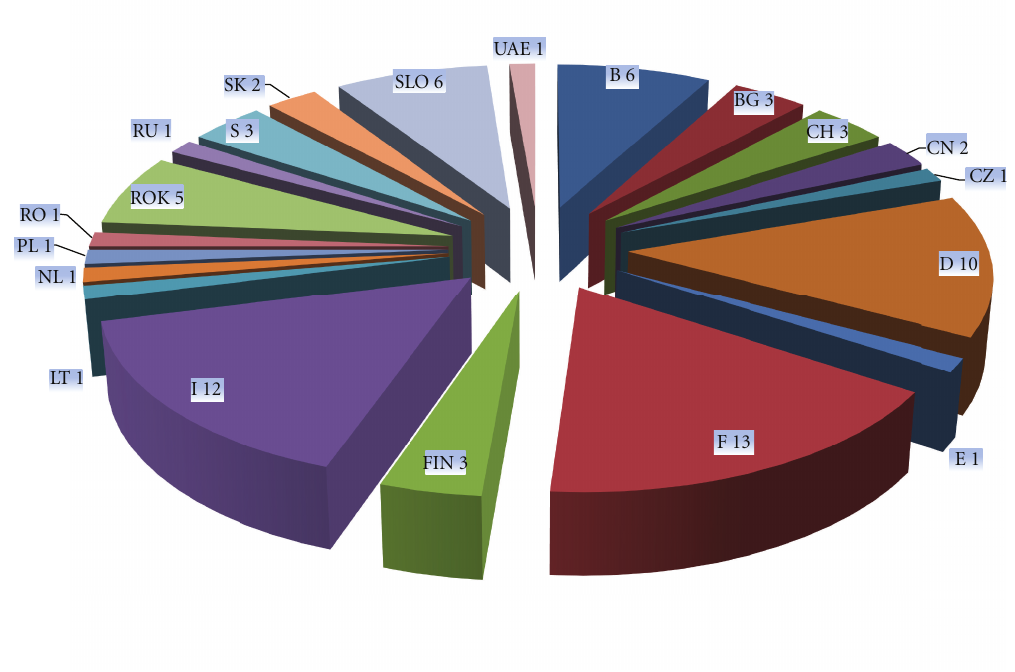
Figure 2: Nationalities of the participants in the Pisa 2011